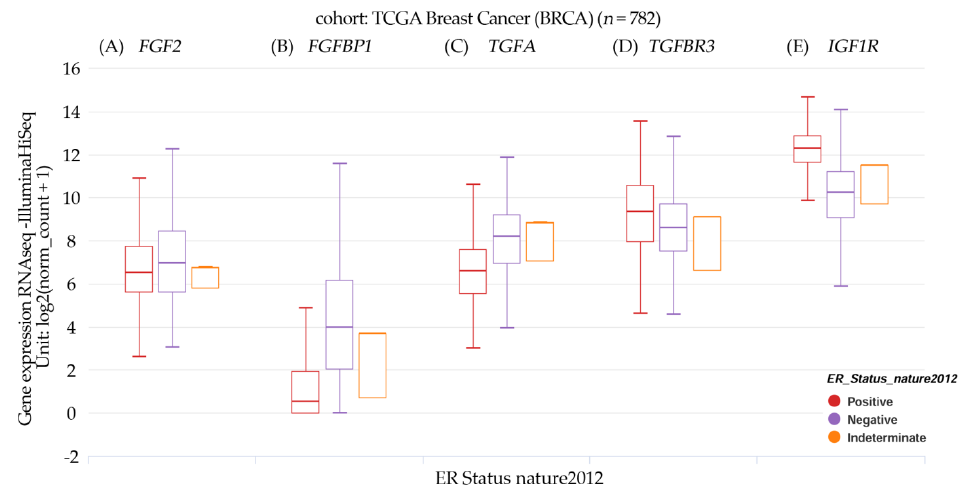
Figure 3. Box plot transcript expression of ( A ) FGF2 , ( B ) FGFBP1 , ( C ) TGFA , ( D ) TGFBR3 , and ( E ) IGF1R in breast cancer (TCGA, n = 782) stratified by nature2012 for the estrogen receptor status (One-way ANOVA, p < 0.05). Raw data were extracted from the University of California, Santa Cruz (http://xena.ucsc.edu/). UCSC Xena functional genomics explorer (accessed 21 August 2021, https://xenabrowser.net) [20].